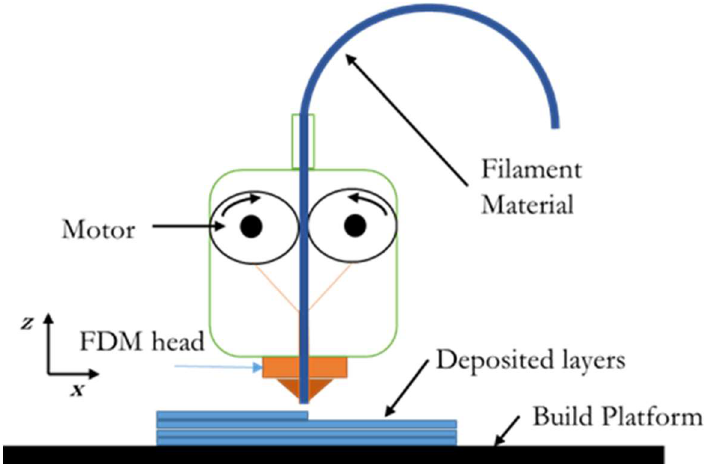
Figure 1. Fused deposition modelling (FDM) process.